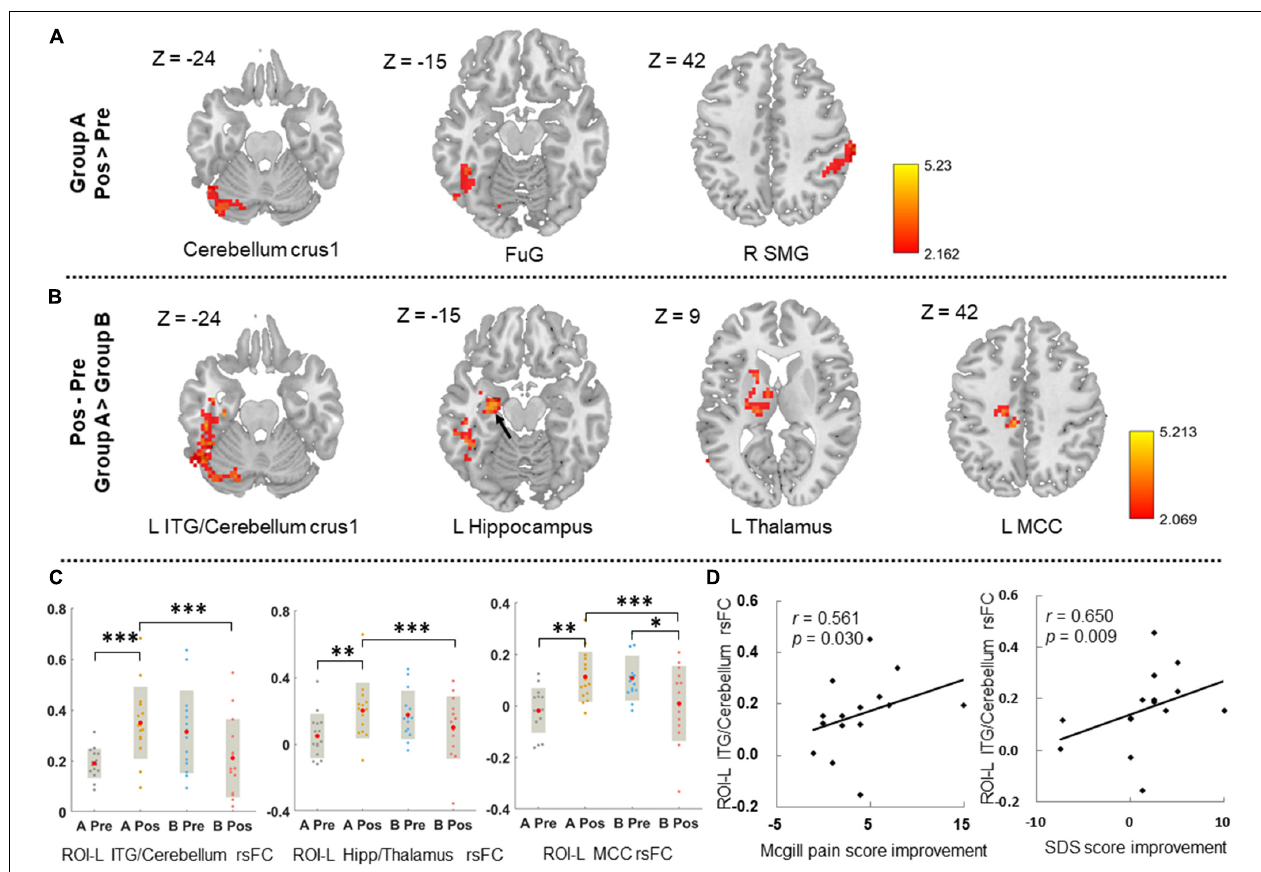
FIGURE 4 | The ROI-based rsFC change after treatment and its correlations with clinical symptoms improvements. (A) Displays the ROI-based rsFC change after treatment in group A. Threshold: voxel-level p < 0.05, cluster-level p-GRF < 0.05. (B) Displays the between-group difference of ROI-based rsFC change after treatment in groups A and B. Threshold: voxel-level p < 0.05, cluster-level p-GRF < 0.05. (C) Illustrates the comparisons of ROI-based rsFC values of the survival regions at pre- and post-treatment in those two groups. (D) Illustrates the correlations between ROI-based rsFC change of the survival regions and clinical symptoms improvements in group A. L, left; R, right; FuG, fusiform gyrus; SMG, supramarginal gyrus; ITG, inferior temporal gyrus; MCC, middle cingulate cortex; Hipp, hippocampus; ROI, region-of-interest; rsFC, resting-state functional connectivity; SDS, self-rating depression scale; ∗ p < 0.05; ∗∗ p < 0.01; ∗∗∗ p < 0.001. The black arrow indicates the location of the left